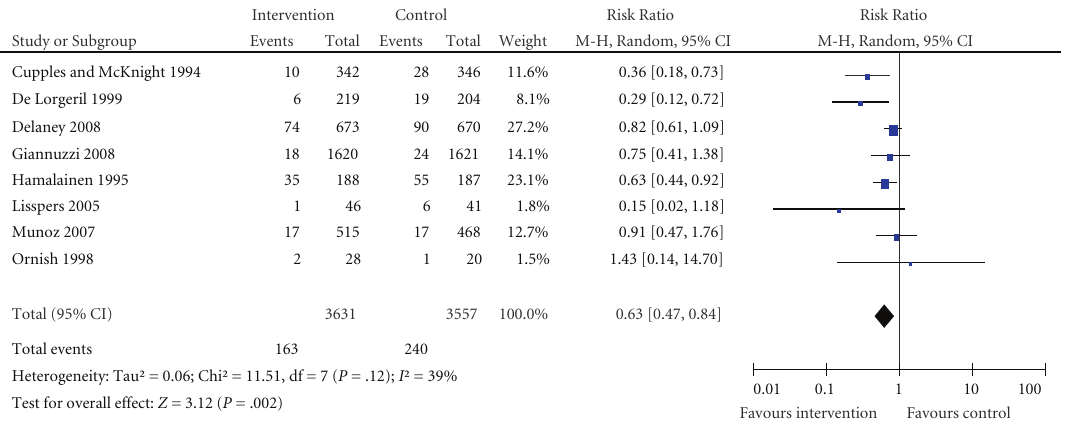
Figure 3: E ff ect of interventions on cardiovascular mortality: comparison of intervention versus control groups.